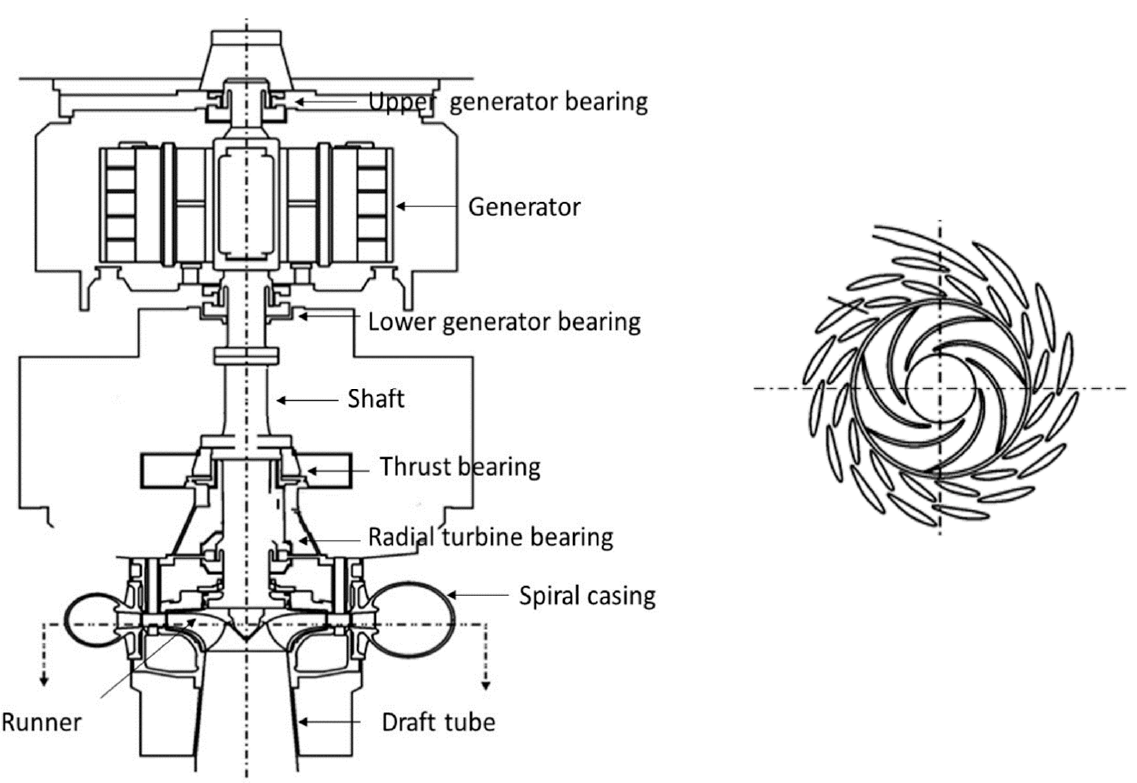
Figure 5. Schematic representation of the pump turbine prototype from the experimental study.